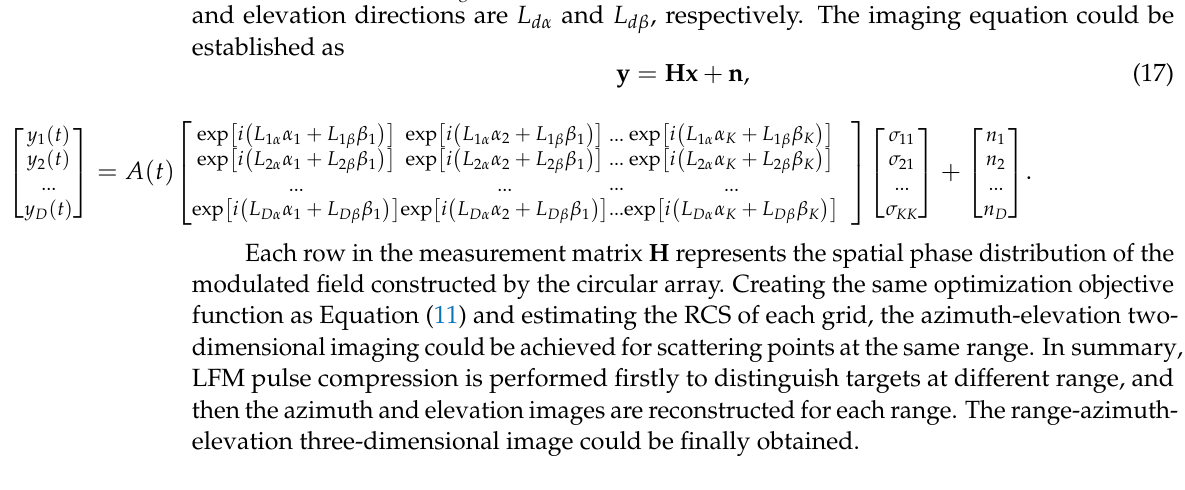
The scattering points with different azimuth and elevation positions at the same range are superimposed together. Assuming that the azimuth and elevation within the main lobe are divided into K × K = M discrete grids, D modulated fields with phase gradient value L and direction ϕ dg are constructed for imaging. The phase gradient in the azimuth and elevation directions are L d α and L d β , respectively. The imaging equation could